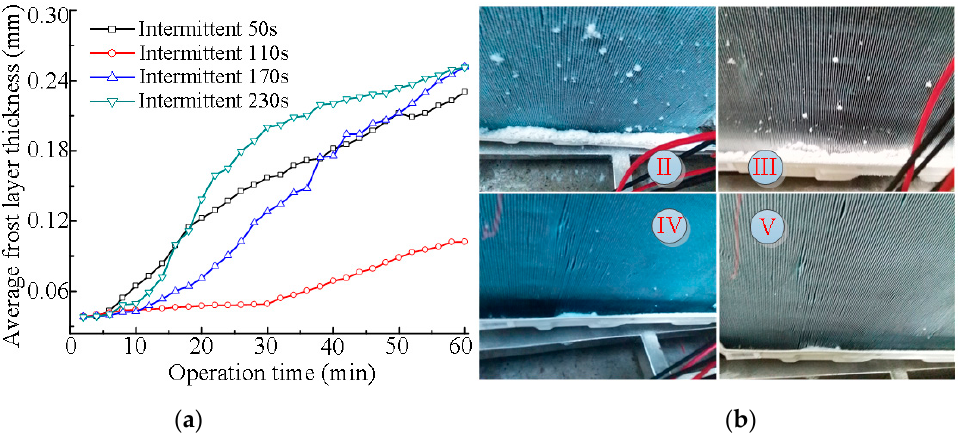
Figure 16. Average frost layer thickness and amount of the frost removed on evaporator. ( a ) Average frost layer thickness; ( b ) macro frosting image of evaporator.